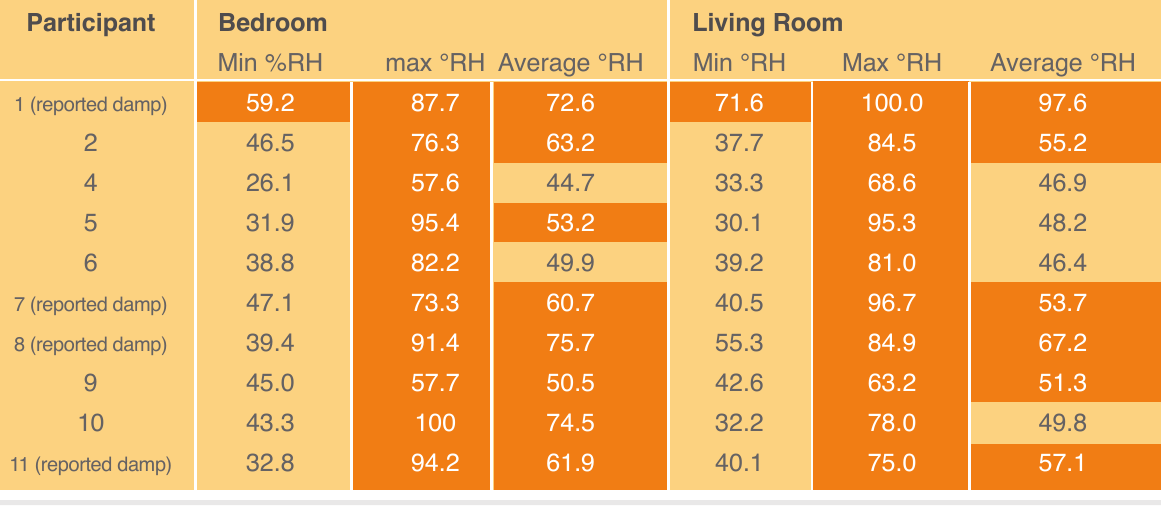
Dark orange shading denotes relative humidity is higher than recommended to reduce allergens such as mould and dust mites Arlian et al (2001) state that a relative humidity of less than 50% is recommended for reducing allergens such as mould and dust mites in homes. The dark orange shaded data in the table above show